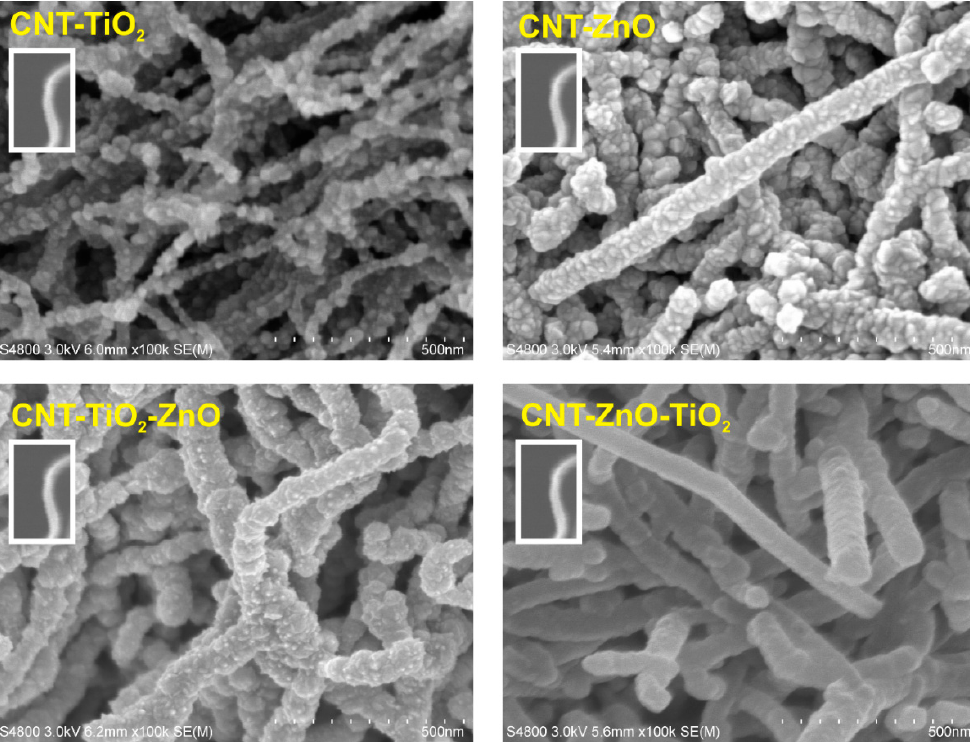
Figure 4. SEM images of the samples. In the white frame, the SEM picture of an uncoated CNT-OH is shown at the same magnification for reference.